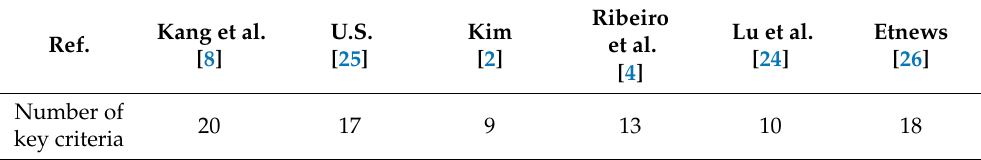
Table 3. Numbers of key criteria for the evaluation of RPA selection collected through preliminary